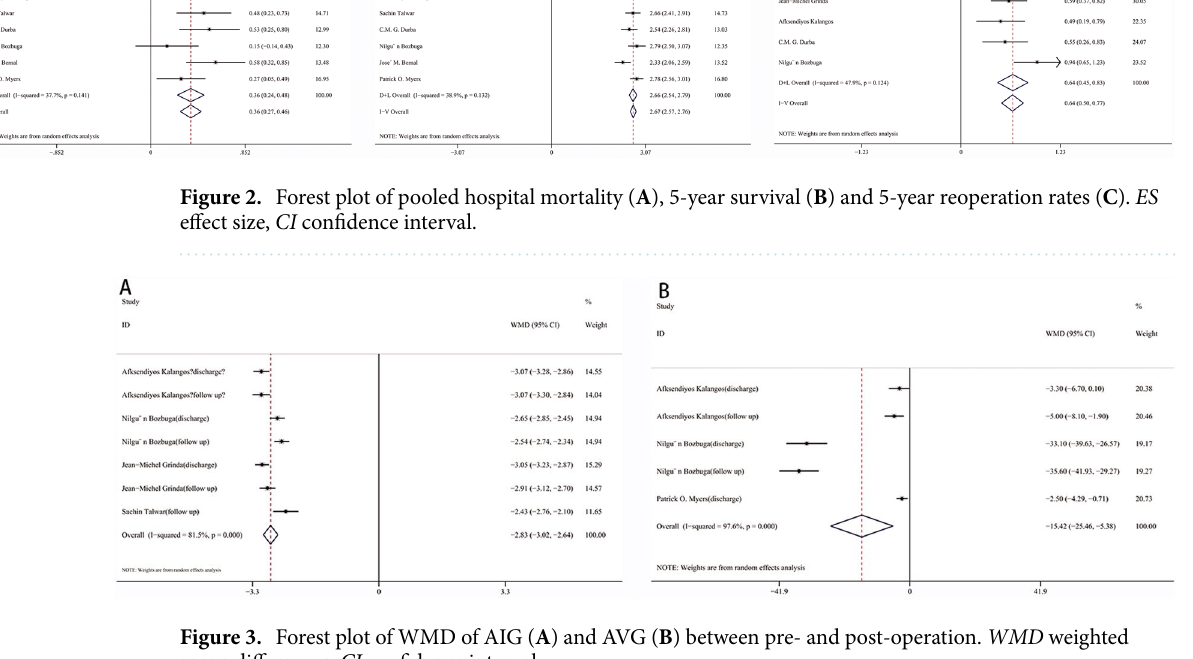
Figure 3. Forest plot of WMD of AIG ( A ) and AVG ( B ) between pre- and post-operation. WMD weighted mean differences, CI confidence interval.